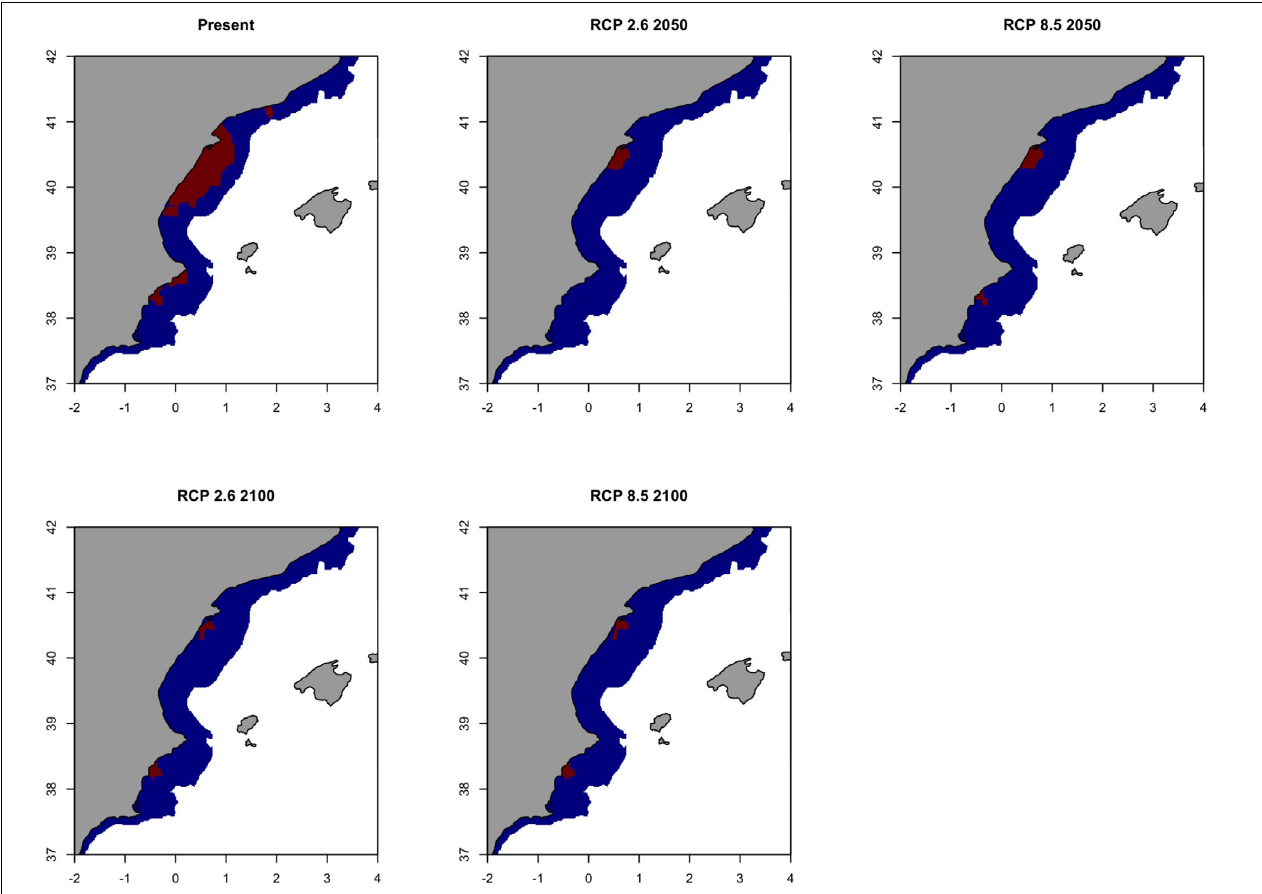
FIGURE 9 | Climate refuges, hot-spots of the probability of occurrence ( > 0.7) of the European sardine ( Sardina pilchardus ) in Geographical Sub-Area 06 for the present situation and using IPCC pathway scenarios obtained with RAC-BRT models. Red color indicates probability of occurrence > 0.7, while blue < 0.7.